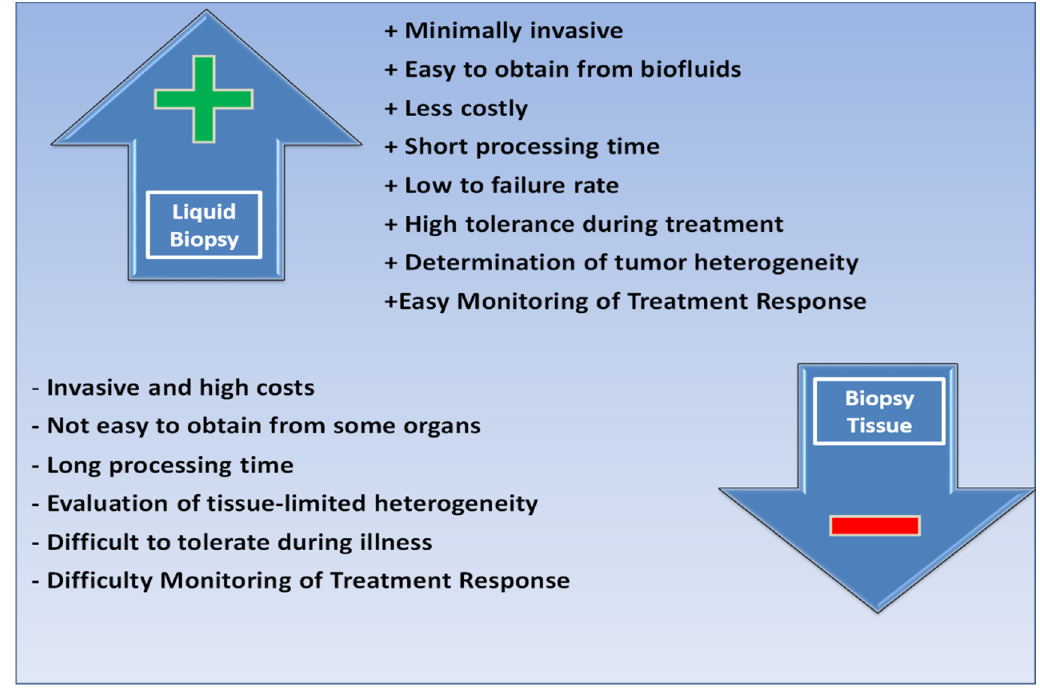
Figure 2. Comparison of tissue biopsy and liquid biopsy.